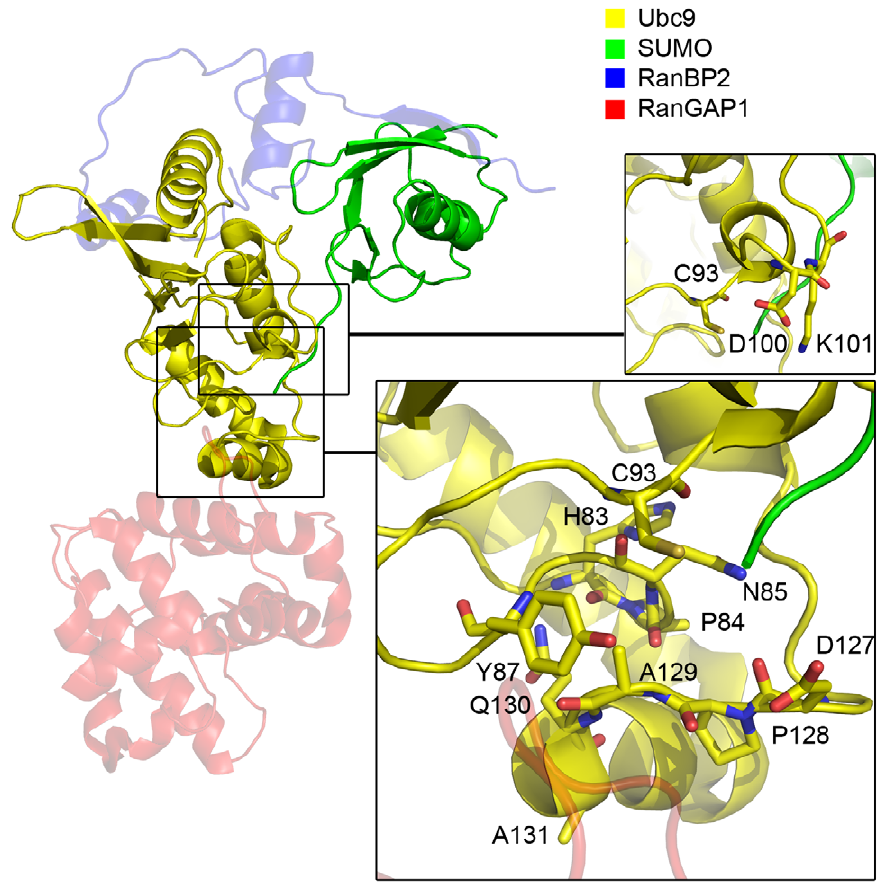
Figure 2. The structure of the Ubc9-SUMO-RanBP2-RanGAP1 complex [ 20 ] . The chains are colored as indicated in the legend. The insets highlight the residue groups that are of interest. Top: The Ubc9 loop with the Asp100 and Lys101, active Cys93 is also represented in sticks. Bottom: The residues interacting with the sumoylation motif of target proteins. Detailed version is given in Figure S5.